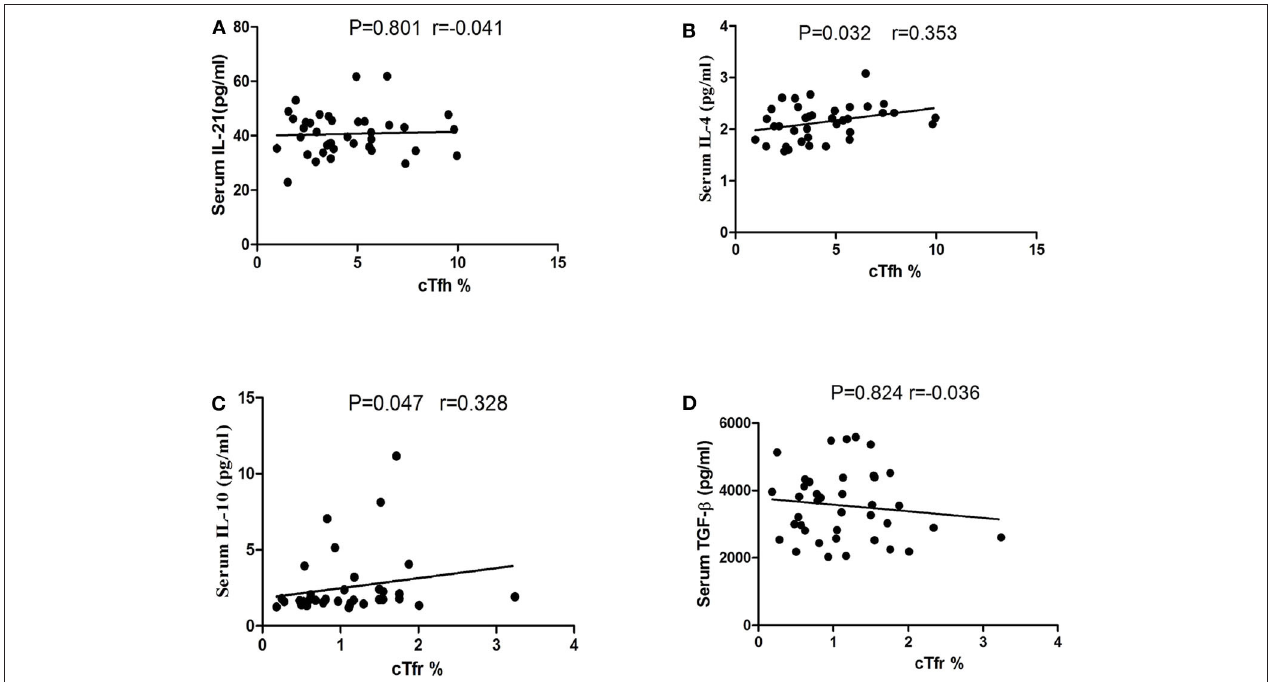
FIGURE 5 | Correlation analysis of cTfh, cTfr with IL-21, IL-4, IL-10, and TGF- β in PD patients. (A) The correlation analysis of the percentages of cTfh cells with the serum IL-21 concentrations in PD patients ( P = 0.801). (B) The correlation analysis of the percentages of cTfh cells with the serum IL-4 concentrations in PD patients ( P = 0.032). (C) The correlation analysis of the percentages of cTfr cells with the serum IL-10 concentrations in PD patients ( P = 0.047). (D) The correlation analysis of the percentages of cTfr cells with the serum TGF- β concentrations in PD patients ( P =